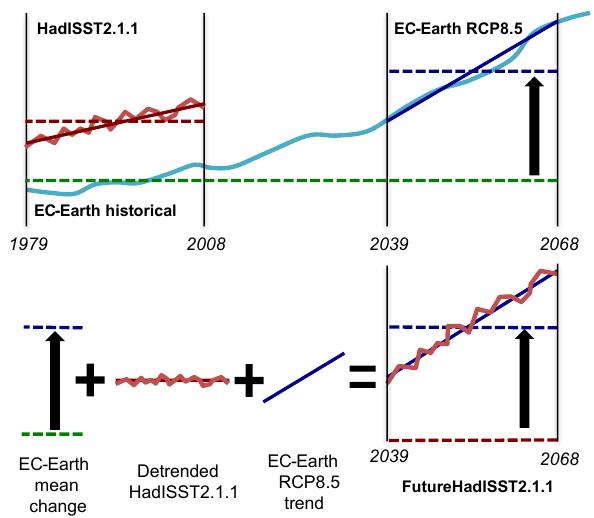
Figure 2. Scheme representing the methodology adopted to cre- ate the FutureHadISST 2.1.1. The new dataset is a combination of detrended daily variability from HadISST 2.1.1, CMIP5 EC-Earth mean change and CMIP5 EC-Earth RCP8.5